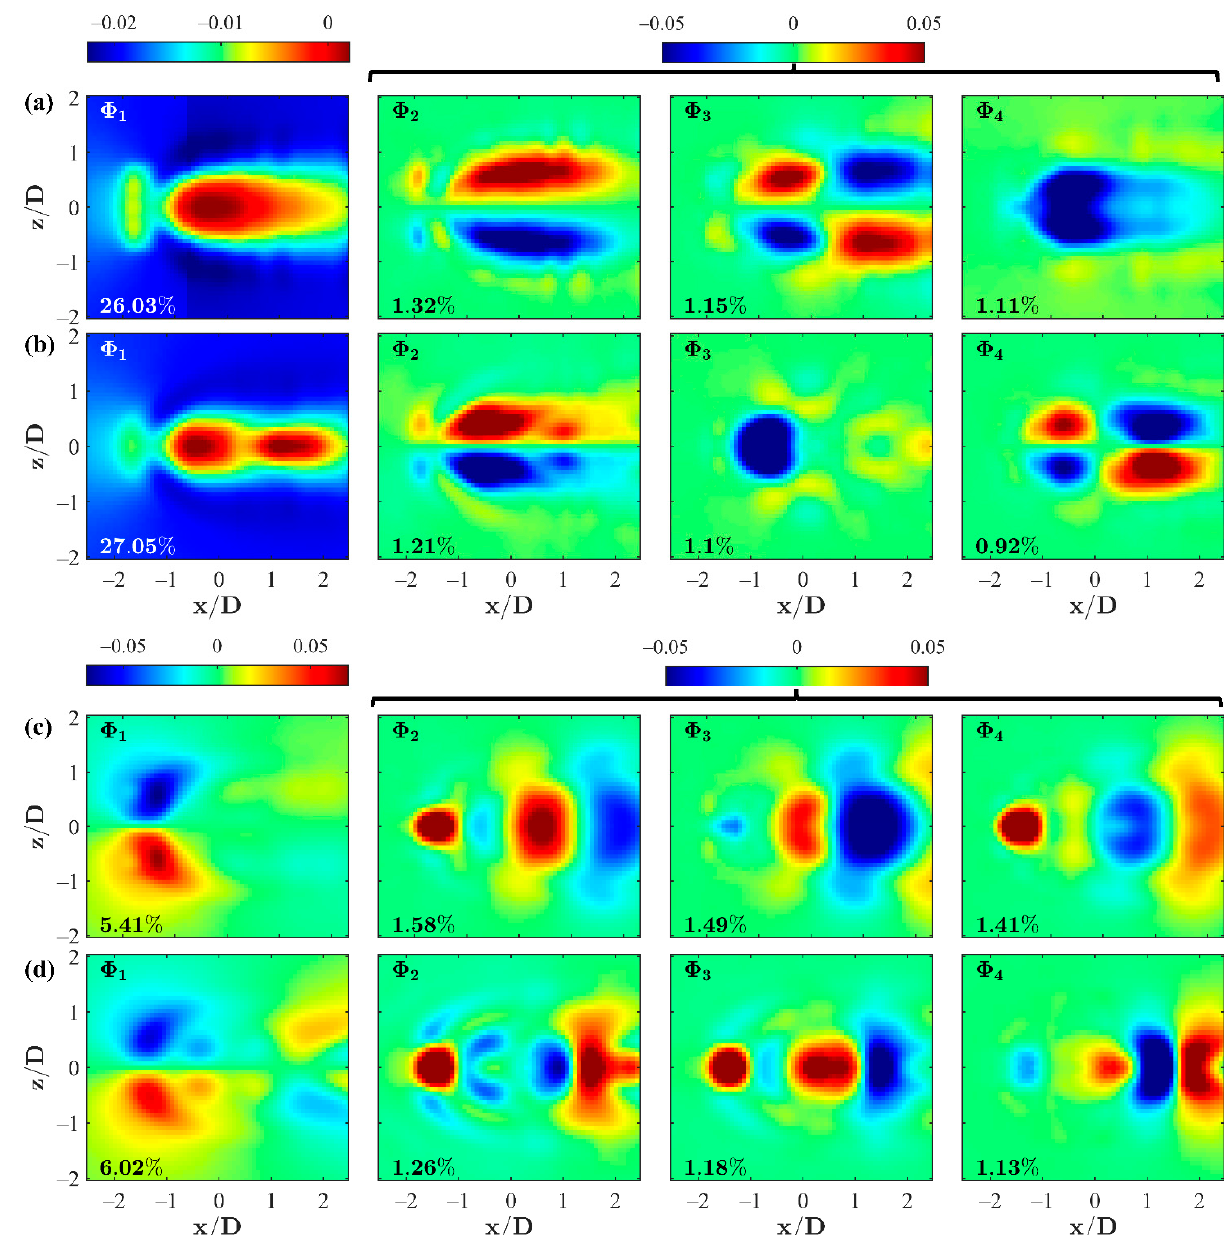
Figure 6. Low-order POD velocity mode shapes for the V j /U ∞ = 1.25 for the U ( x,z,t ) ( a ) composite and ( b ) measured data sets and the W ( x,z,t ) ( c ) composite and ( d ) measured data sets. Relative percent energies are displayed in the bottom left corner of each contour.